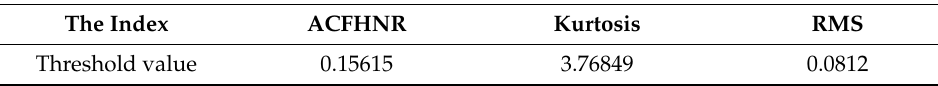
Figure 20. The discrete probability distribution for parameters at the stationary stage: ( a ) ACFHNR; ( b ) root-mean-square (RMS); ( c ) kurtosis. Table 2. The threshold values of the three indexes. Table 3. The sensitivity value of the three indexes in the incipient fault stage.